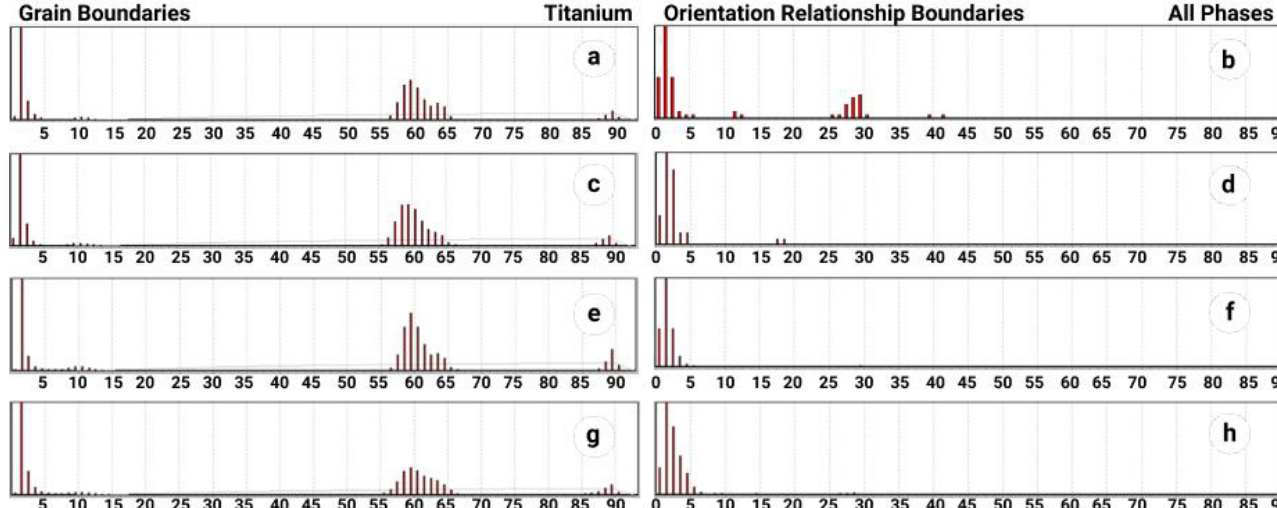
Figure 5. Spectra of grain boundaries by misorientation in the α-phase (left column) and deviations of interphase boundaries from Burgers OR (right column): ( a , b )—S1; ( c , d )—S2; ( e , f )—S3; ( g , h )—S4.